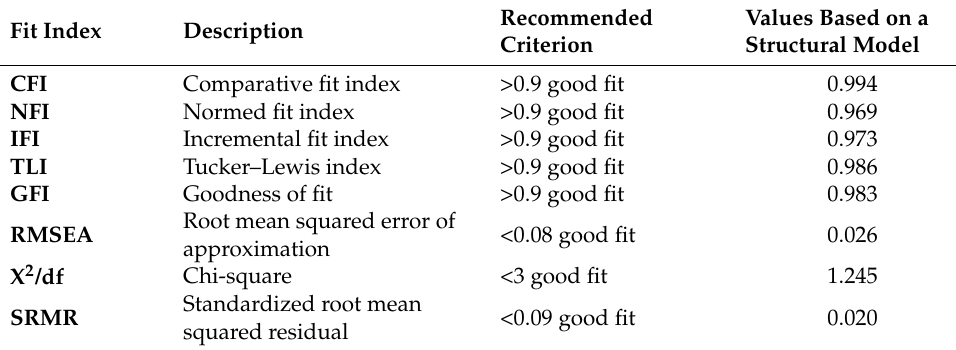
Table 13. Goodness-of-fit indices values of the measurement and structural model.